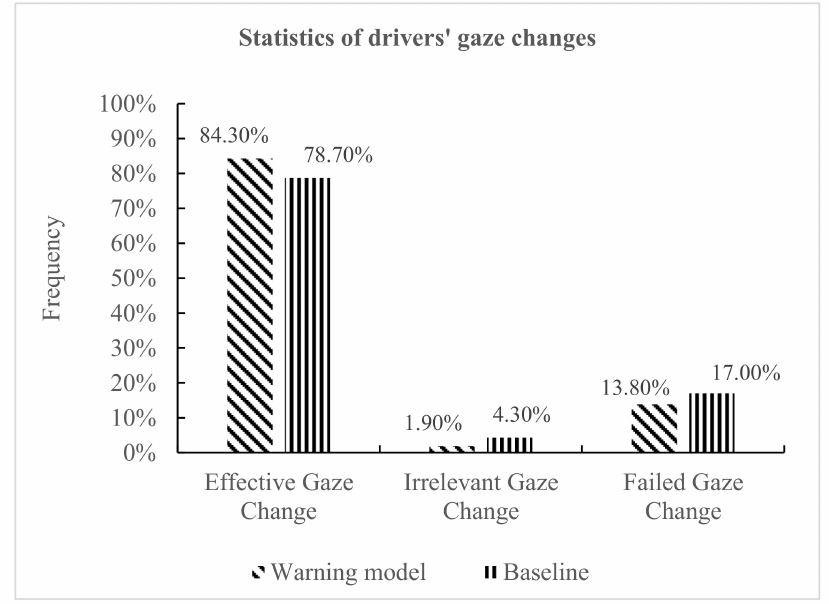
Figure 14. Statistics of gaze changes under warning model and no warning model scenarios.